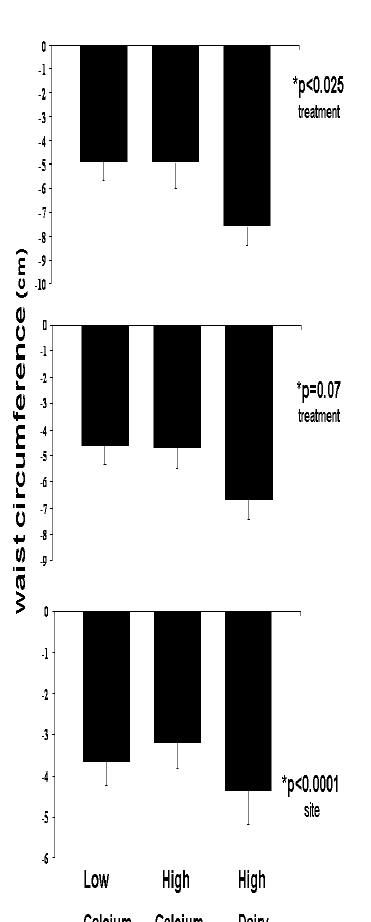
Figure 5. Effects of dietary treatments on change in waist circumference. Top panel: Adherent subjects. Middle panel: All subjects completing the study. Bottom panel: Intent- to-treat analysis. All data are presented as mean ± standard error.